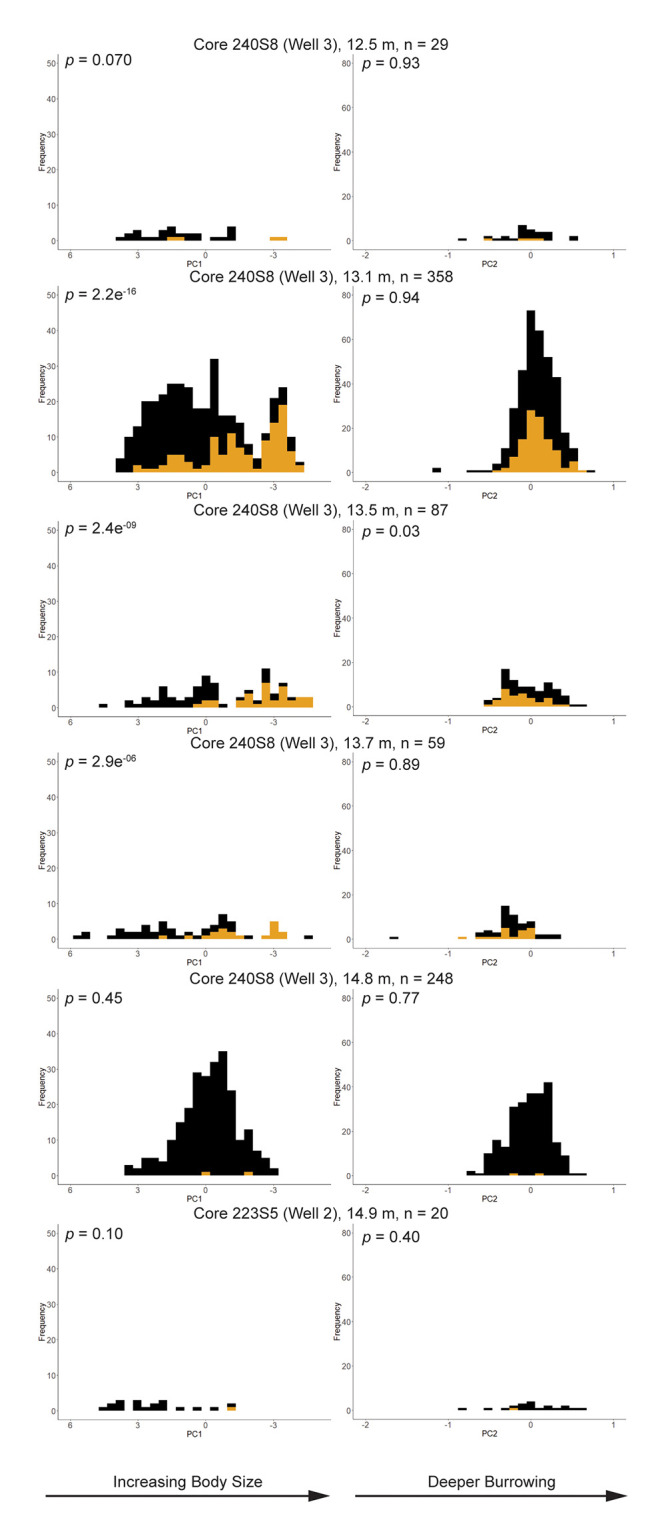
Frequency distributions of PC1 (left column) and PC2 (right column) scores by sample.The p-values are for Wilcoxon tests comparing median values of PC scores for infected (yellow) and uninfected (black) C. gallina valves.